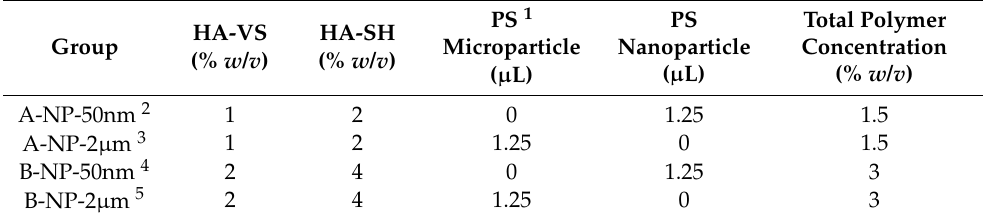
Table 2. Abbreviation and composition of the tested groups for particle behavior study.